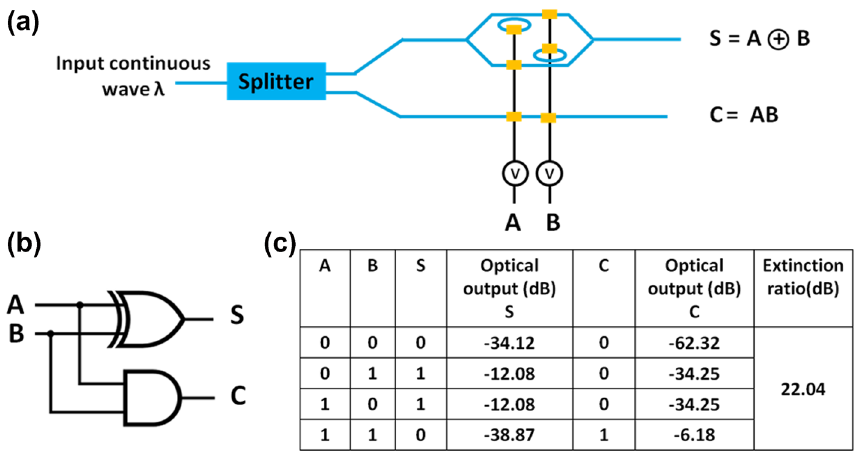
Figure 6. ( a ) Electro-optic architecture, ( b ) graphical symbol, and ( c ) truth table of a 1-bit half adder circuit. While the blue colored connecting lines indicate the optical connections using silicon waveguides, the black colored connecting lines indicate the electrical connections using copper transmission